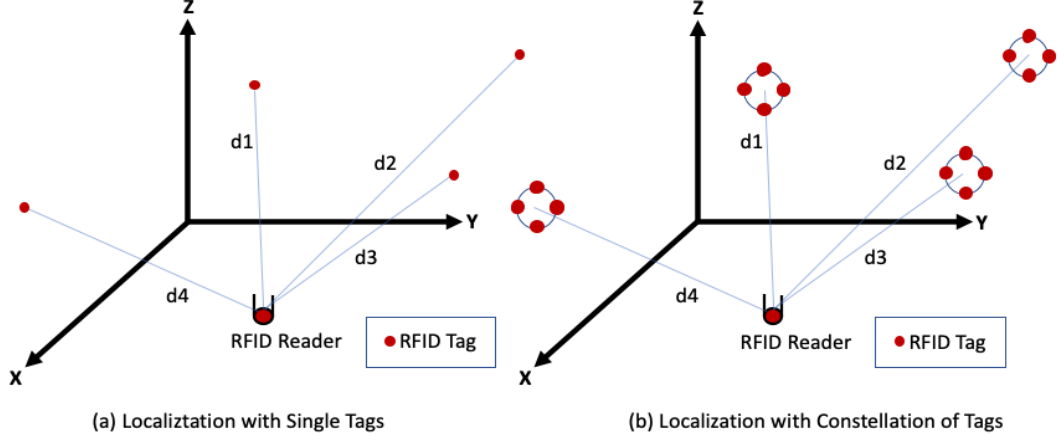
Figure 13. Multilateration technique applied for both the constellation of tags and single tag scenarios.